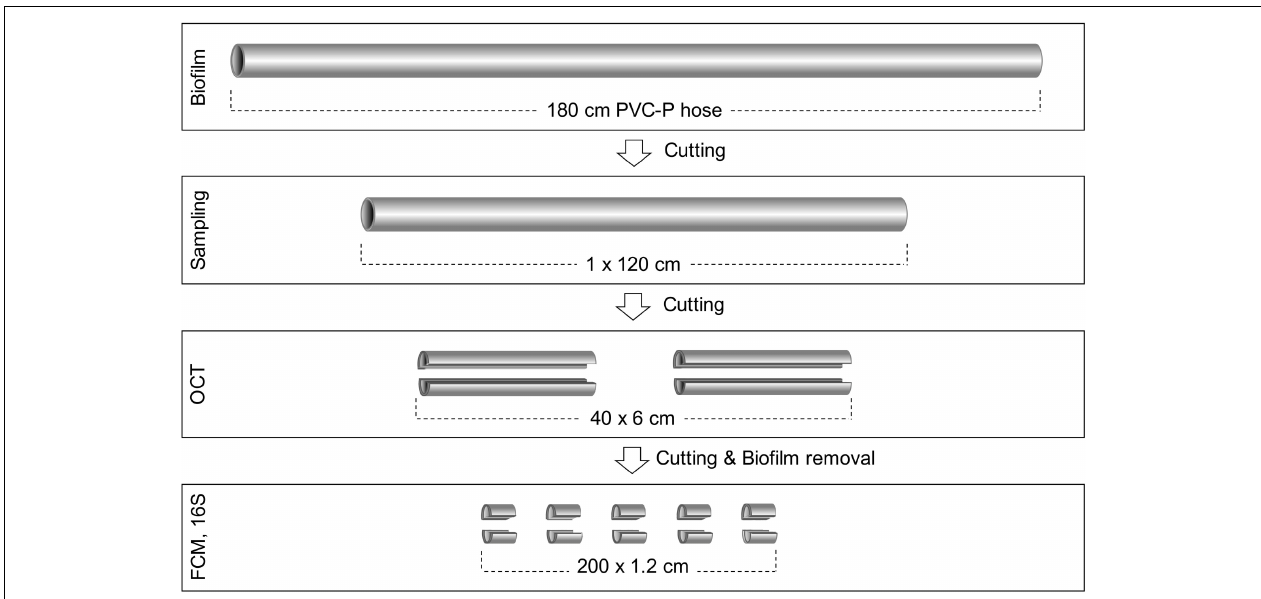
FIGURE 1 | Experimental setup and sample processing. The control hose was horizontally aligned and flushed twice daily. The real hose hung vertically with a bend at the lower end and was used regularly (uncontrolled). The sampling strategy was identical for both hoses. A 120 cm section of each hose was extracted, then cut in 6 cm sections, horizontally bisected and imaged with optical coherence tomography for biofilm thickness. The 6 cm pieces were then cut into 1.2 cm sections followed by biofilm removal, which was then analyzed with flow cytometry for total cell counts and 16S rRNA amplicon sequencing for community